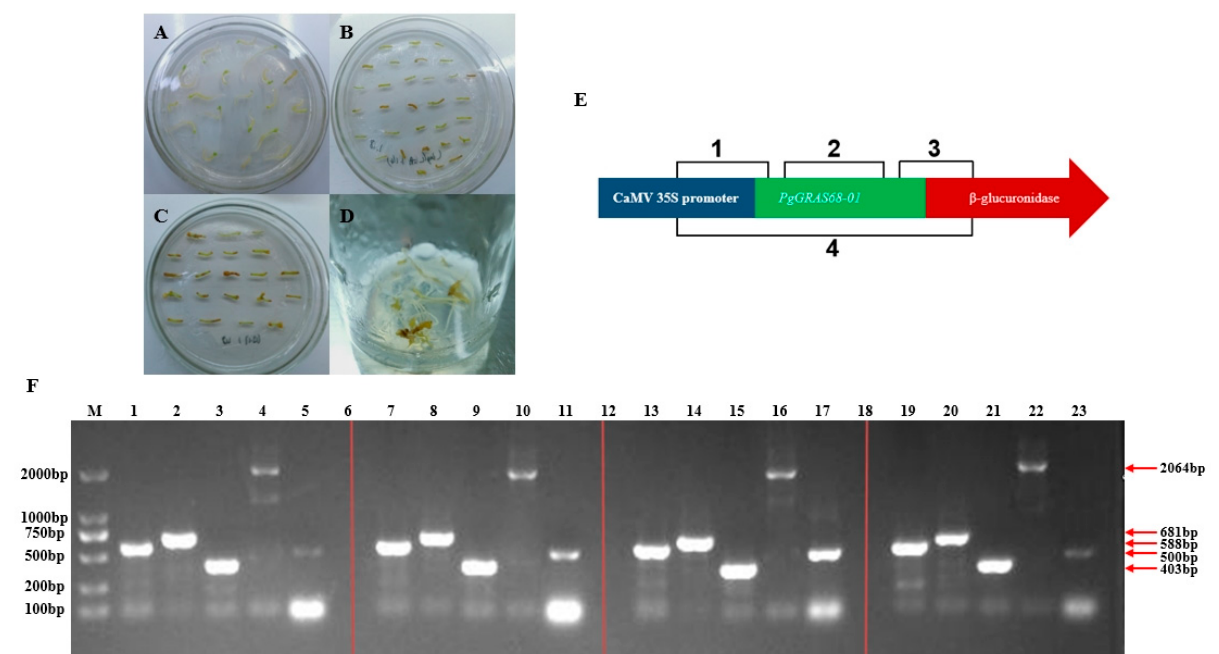
Figure 8. Parameter explants were transformed with recombinant plasmids. ( A ) Leaf handle and root preculture. ( B ) Coculture with Agrobacterium tumefaciens . ( C ) Positive hairy roots. ( D ) Culture of positive hairy roots. ( E ) Design of primers for PCR positive validation. ( F ) PCR method tests for some of positive ginseng hairy roots strains. M: Maker; 1–5, 7–11, 13–17, 19–23: Positive ginseng hairy roots.